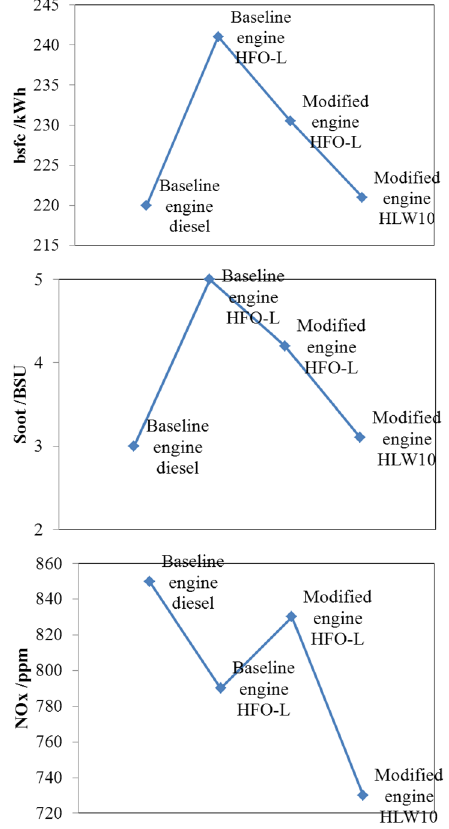
Figure 19. Engine performance improvement strategy.